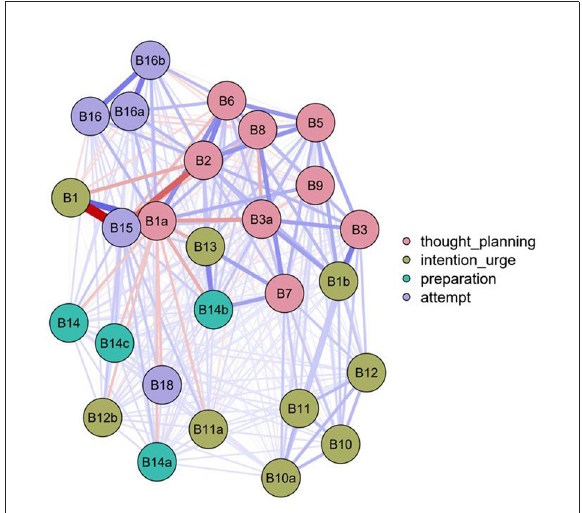
FIGURE1 Unregularized Ising networks were estimated for all four facets of disorders separately to map the factor structure.